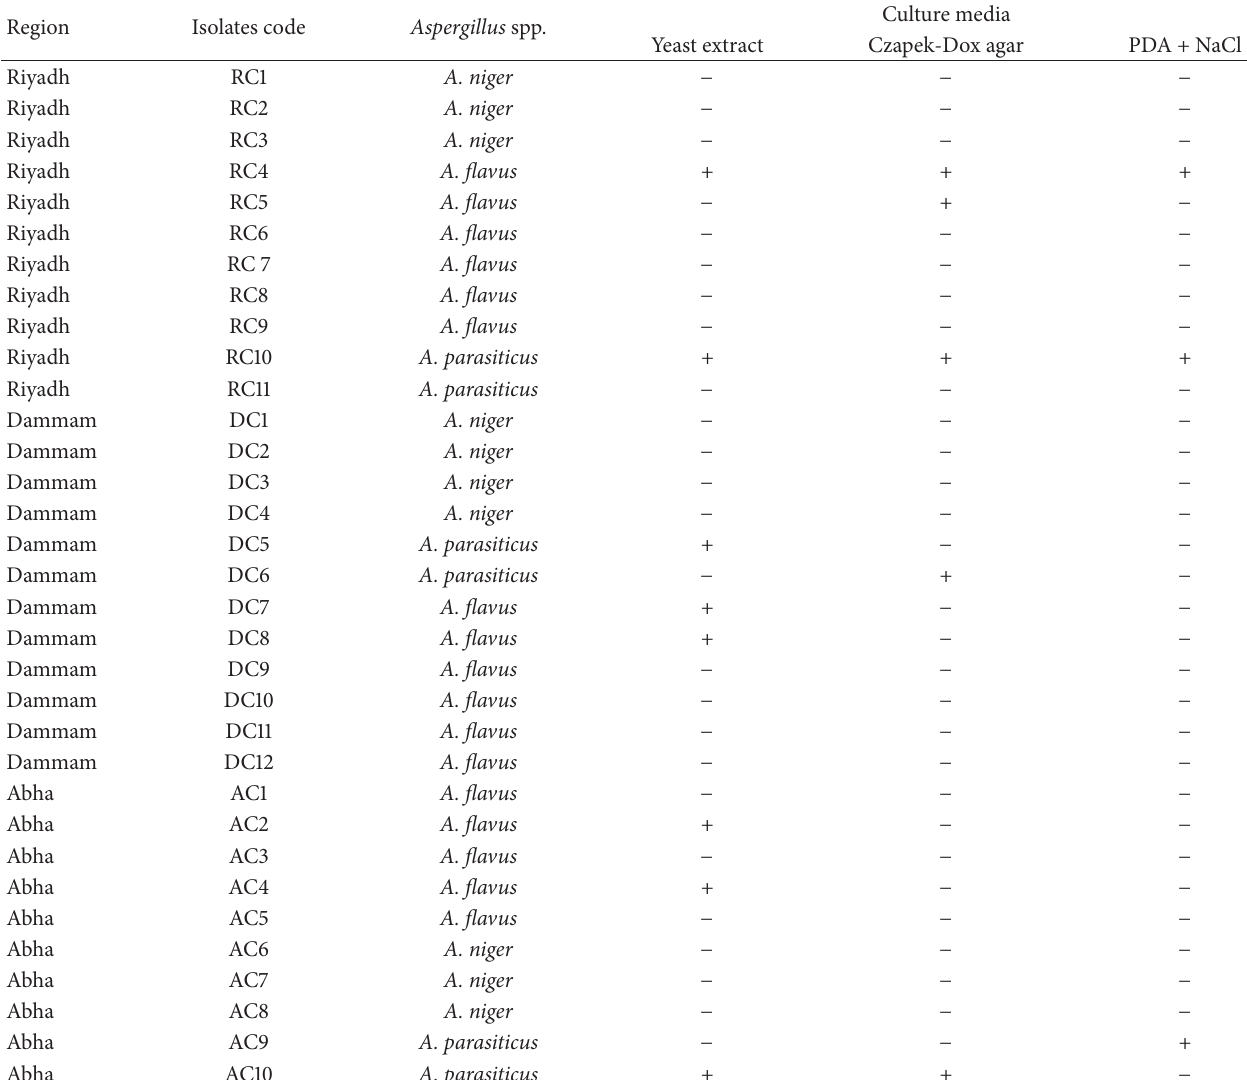
Table 2: Detection of aflatoxins produced by Aspergillus spp. isolates from cashews via UV